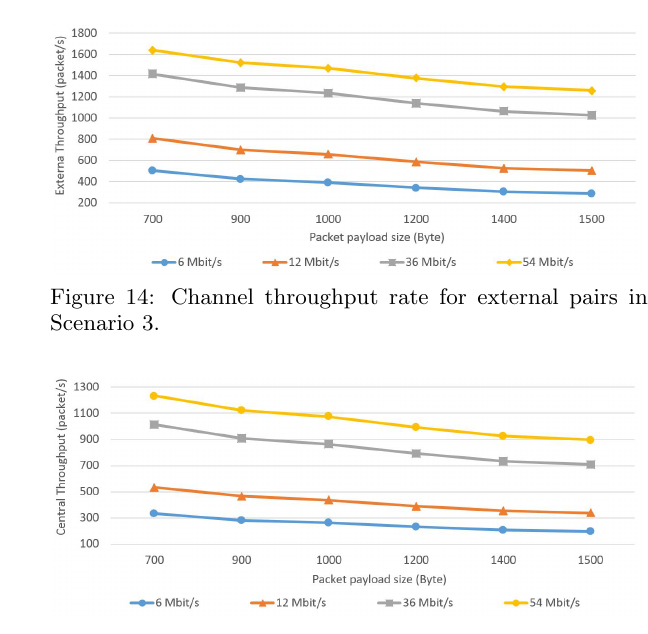
Figure 15: Channel throughput rate for central pairs in Sce- nario